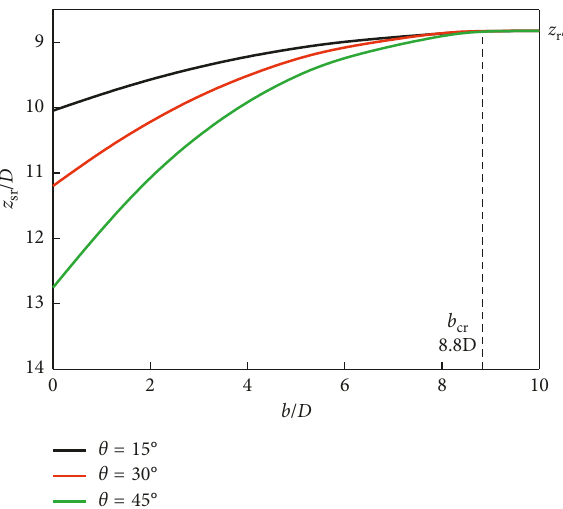
Figure 11: The relationship between z ( C u �